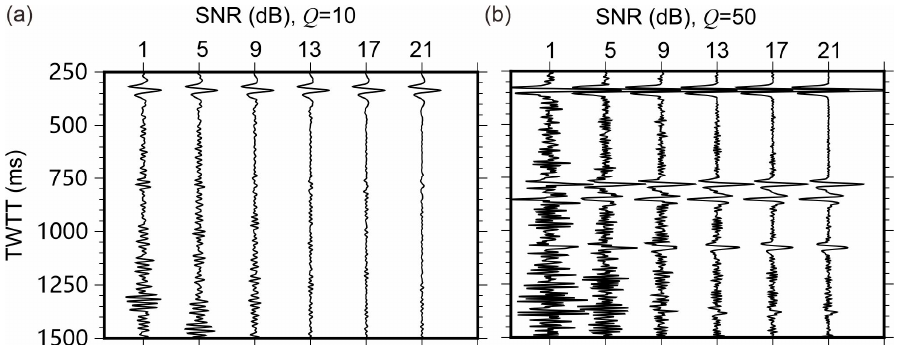
Figure 3. Results obtained by stabilized inverse- Q filtering: ( a ) Q = 10, ( b ) Q = 50. Note that the amplitudes of noise increase to the bottom of the section, resembling an automatic gain control (AGC) effect.